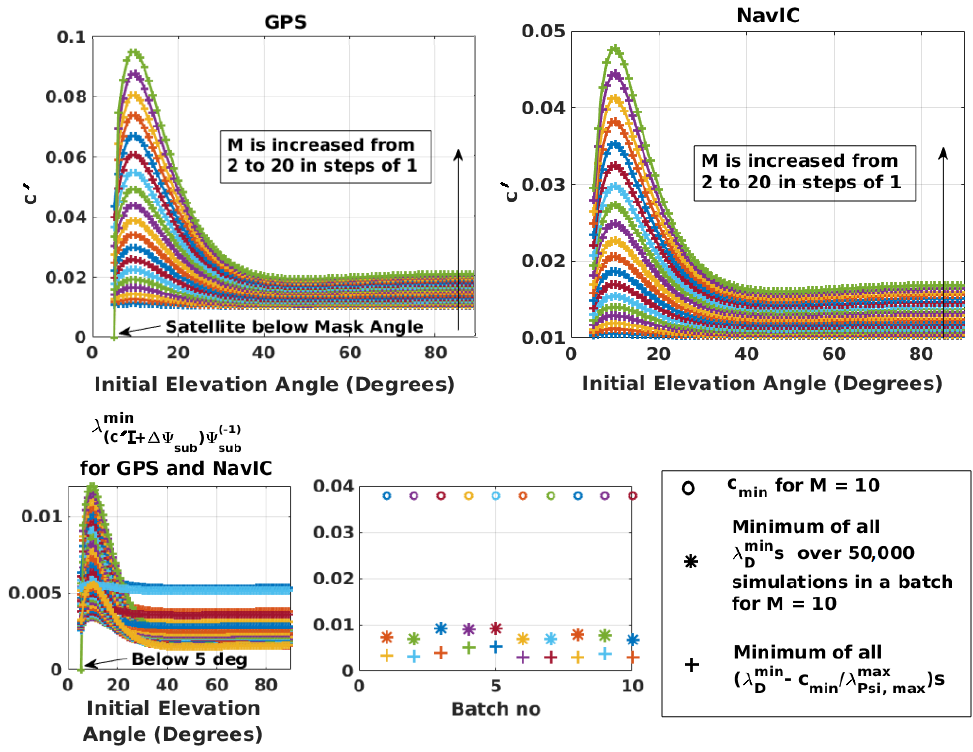
Figure A1. c (cid:48) and λ min for clarity), and c min and minimum of λ min